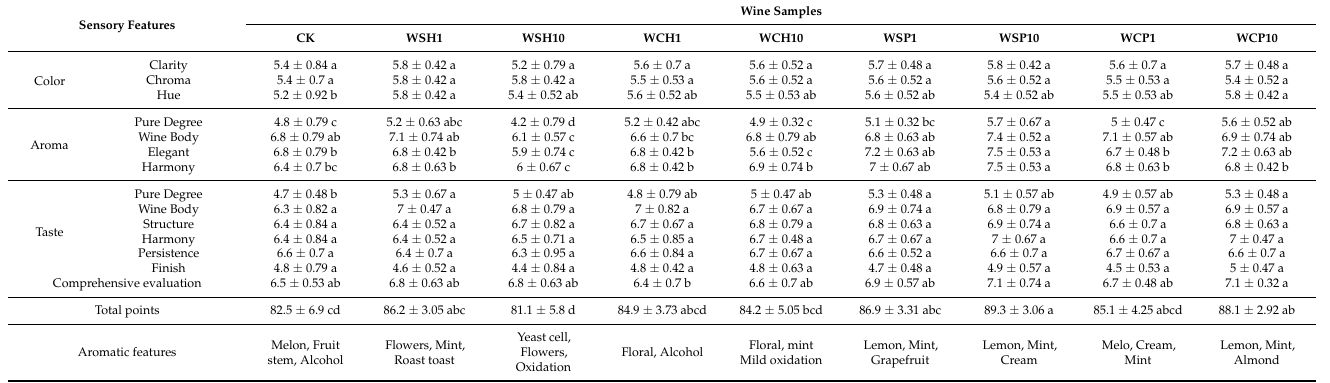
Table 6. Sensory quality score and sensory characteristics of wine